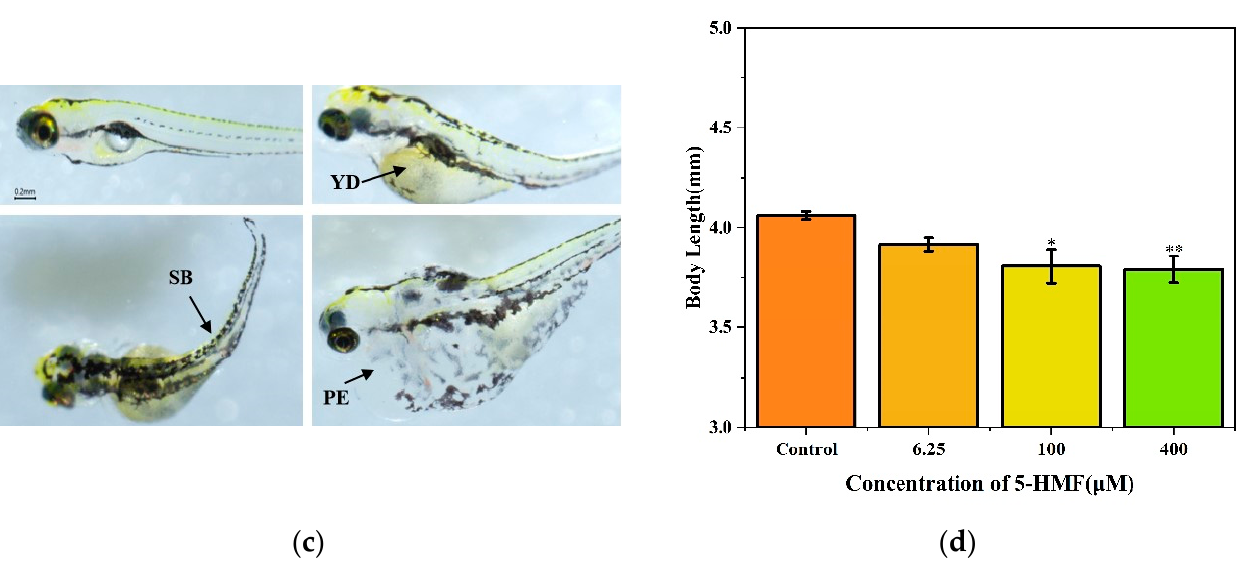
Figure 2. Developmental toxicity and teratogenicity of zebrafish larvae exposed to different concen- Figure 2. Effect of different concentrations of milk powder matrix incubation for 120 h on zebrafish trations of 5-HMF for 120 h. ( a ) Death rate of zebrafish embryos treated with different concentrations larvae. ( a ) Survival rate of zebrafish embryos cultured with different concentrations of milk pow- der matrix; ( b ) Hatching rate of zebrafish embryos cultured with different concentrations of milk of 5-HMF; ( b ) Malformation rate of zebrafish embryos treated with different concentrations of 5- powder matrix; ( c ) Development of zebrafish larvae cultured with low concentration milk powder HMF; ( c ) Malformation of zebrafish larvae treated with high concentrations of 5-HMF, abbrevia- matrix; ( d ) Body length of zebrafish larvae cultured with low concentration of milk powder matrix. tions: PE, pericardial edema; SB, spinal bending; YD, delayed absorption of yolk sac; ( d ) Body length Abbreviations: Milk, milk powder matrix. *** p < 0.001 vs. control. of zebrafish larvae treated with different concentrations of 5-HMF. * p < 0.05, ** p < 0.01 and *** p < 0.001 vs. control.